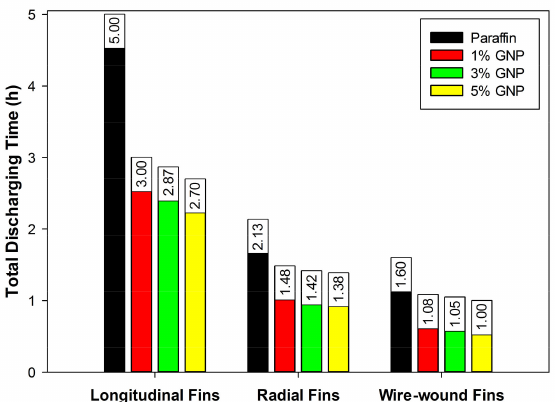
Figure 8. Total discharging time for paraffin and nano-PCMs in shell-and-tube with longitudinal, radial and wire-wound fins.